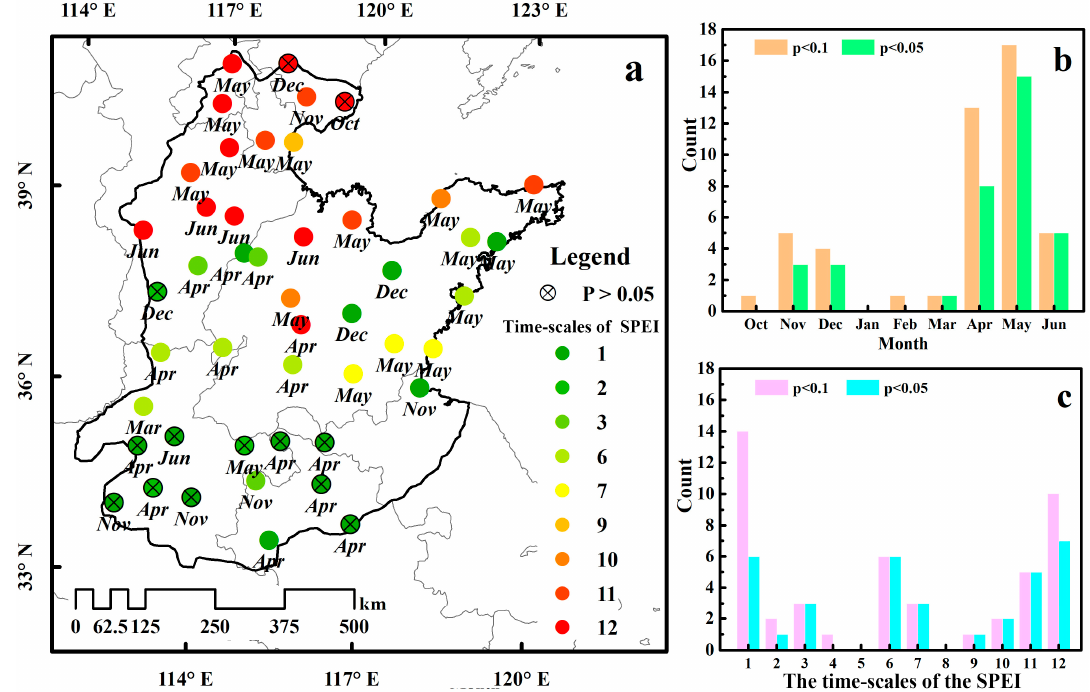
Figure 8. ( a ) Spatial map of best SPEI timescale and month at each station. The best timescale of the SPEI refers to the time ‐ scale when the correlation coefficient reaches the highest between winter wheat yield and SPEI, the best month of the SPEI refers to the month when the correlation coefficient reaches the highest between winter wheat yield and SPEI. ( b ) Histograms of months with the best relationship between the SPEI and winter wheat yield across all stations ( c ) Distributions of the timescales of SPEI with the best relationship between the SPEI and winter wheat yield across all stations. Water 2020 , 12 , x FOR PEER REVIEW